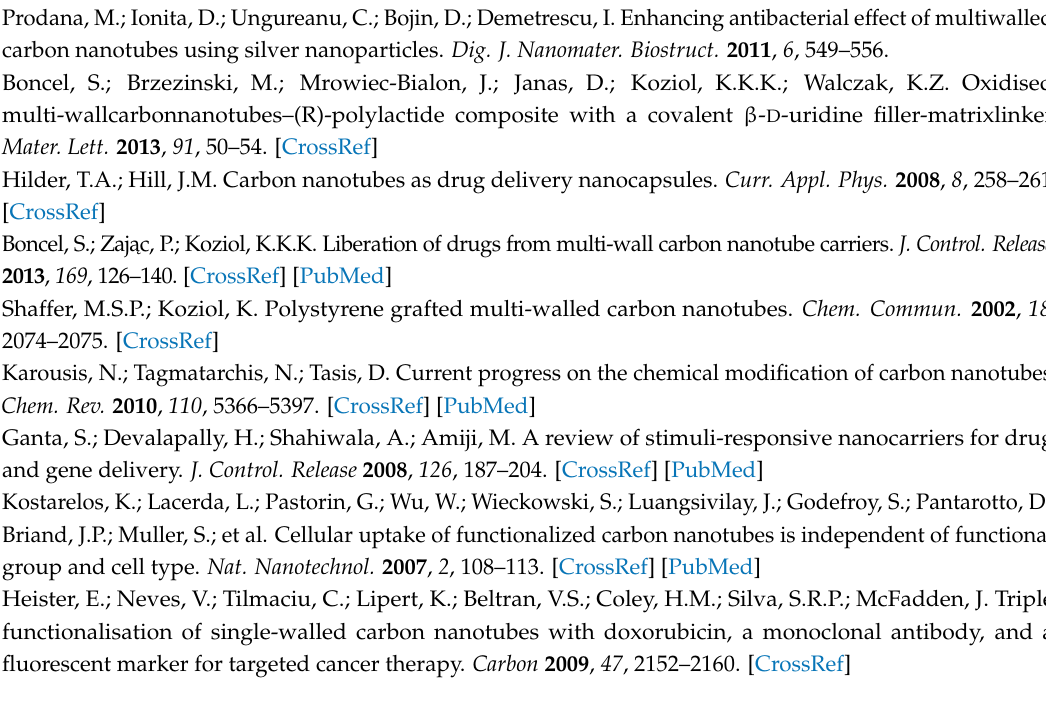
Figure S1: The level of LDH released in culture medium by non-tumour MRC-5 cells after 24 h and 48 h of exposure of various concentrations of CDDP (0.316–2.52 µ g/mL) and MWCNT (0.5–4 µ g/mL), Figure S2: Bright-field images presenting MRC-5 cells morphology after exposure to various concentrations of CDDP (0.316–2.52 µ g/mL) and MWCNTs (0.5–4 µ g/mL) for 24 h and 48 h, Figure S3: Relative level of ROS generated after the exposure of MRC-5 cells to CDDP (0.316–2.52 µ g/mL) and MWCNTs (0.5–4 µ g/mL) for 24 h and 48 h, Figure S4: Relative protein expression of Nrf2 after non-tumor MRC-5 cells exposure to 0.63, 1.26 µ g/mL CDDP and 1, 2 µ g/mL MWCNTs for 48